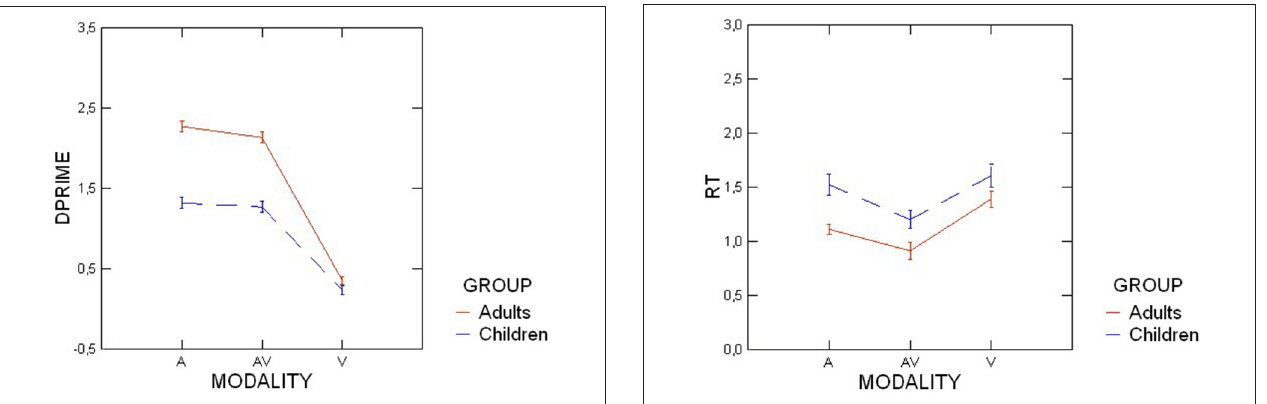
Frontiers in Communication |